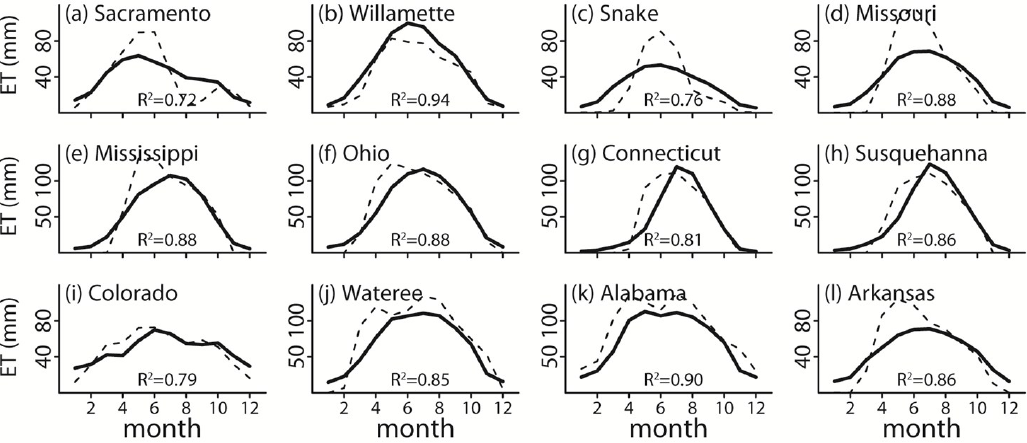
∗ The observed monthly stream flow subtracted that from the Missouri River in model comparison.